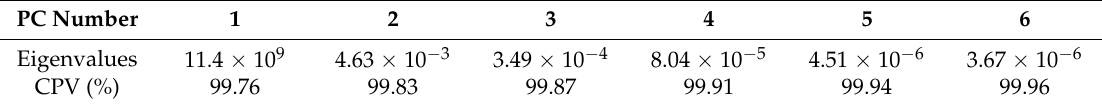
Table 2. CPV precision of the eigenvalues.